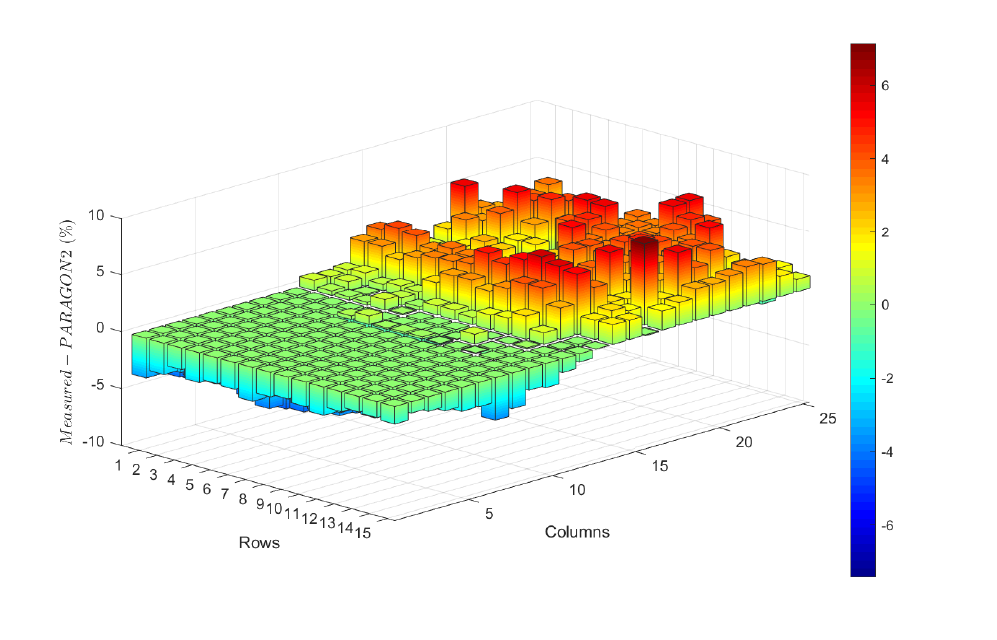
Figure 4: VENUS-2 Experiment: Measured and PARAGON2 Fission Reaction Rates Differences (MOX, UO 4 wt% & 3.3 wt% are in columns: 1 to 8, 9 to 15 and 6 to 25, 2